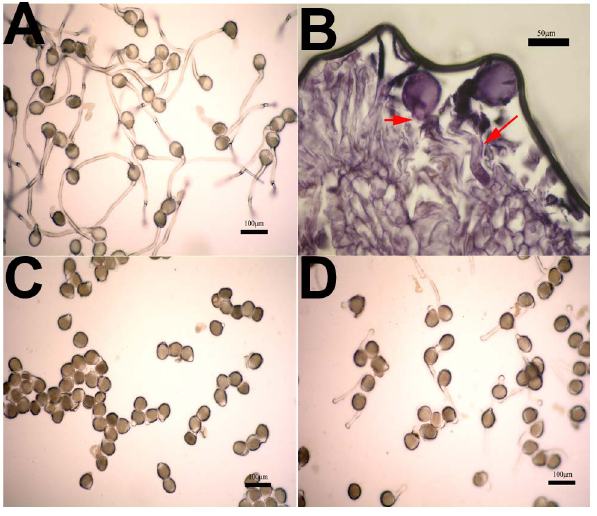
Figure 4. Pollen tubes grow on nutrient medium and pistil. Image A shows pollen tubes grow on nutrient medium after 1 h; image B shows pollen tubes grow on pistil after 1 h, red arrows in image B indicate the spiral pollen tubes; image C shows pollen tubes almost stop growing on nutrient medium with pistil extract which was added at the beginning of germination; image D shows pollen tubes grew more slowly on nutrient medium with pistil extract which was added after 30 min germination.